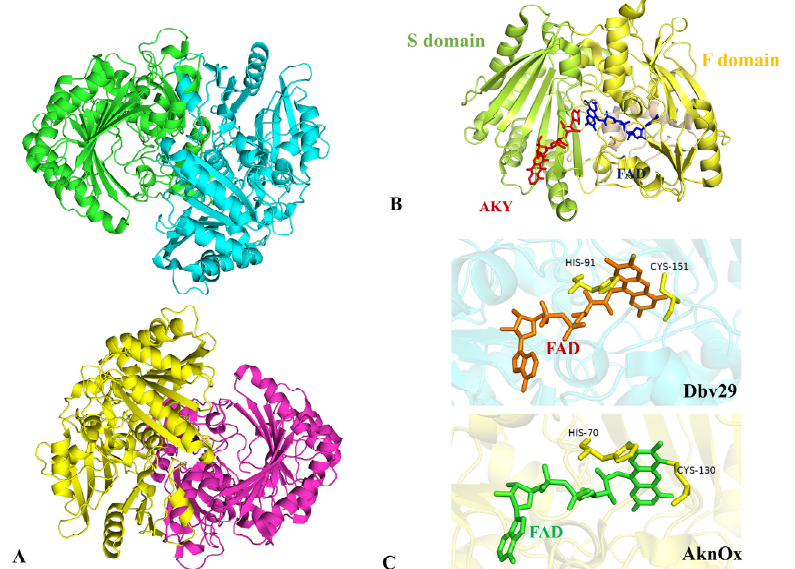
Figure 9. Structure information of AknOx. ( A ) Structure of AknOx; ( B ) The S domain and F domain are shown in yellow and light green, respectively; ( C ) FAD-binding pocket of AknOx and Dbv29.